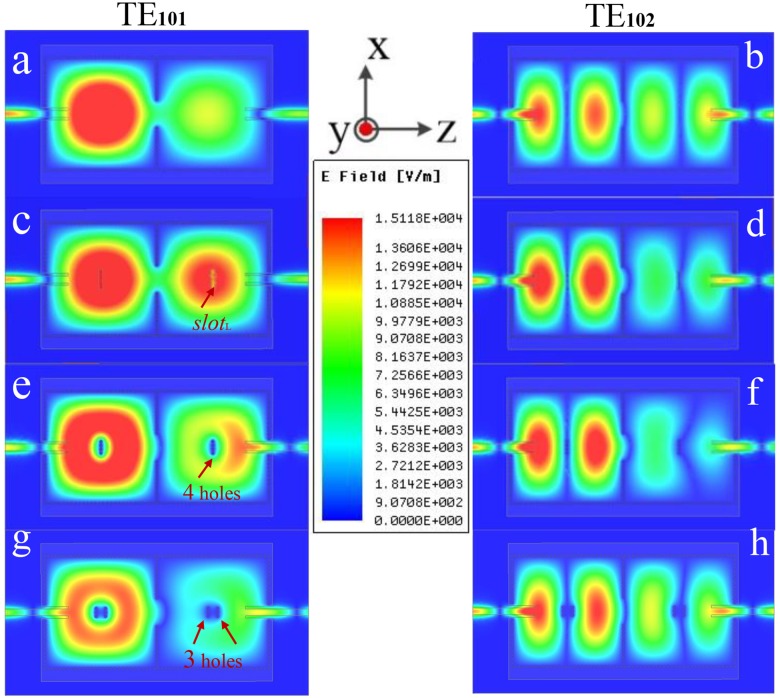
The electromagnetic distributions of the TE101 and the TE102 modes in different perturbation states.The SIW filter is composed of two square cavities in Fig 1, (a-b) The two square cavities without any interference, (c-d) An interference slot with the length of slotL on the vertical line of each square cavity, (e-f) Four perturbation via-holes on the vertical line of each cavity, (g-h) Three perturbation via-holes on each side of the vertical line of each square cavity.